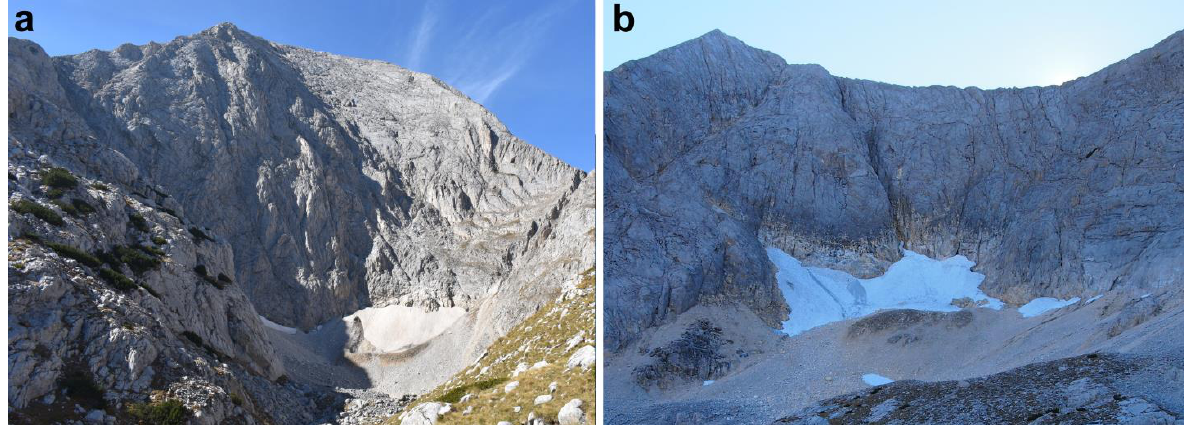
Figure 2. Snezhnika glacieret with Vihren peak in October 2021 ( a ) and Banski suhodol glacieret with Kutelo peak in November 2015 ( b ). Photographs by the author.